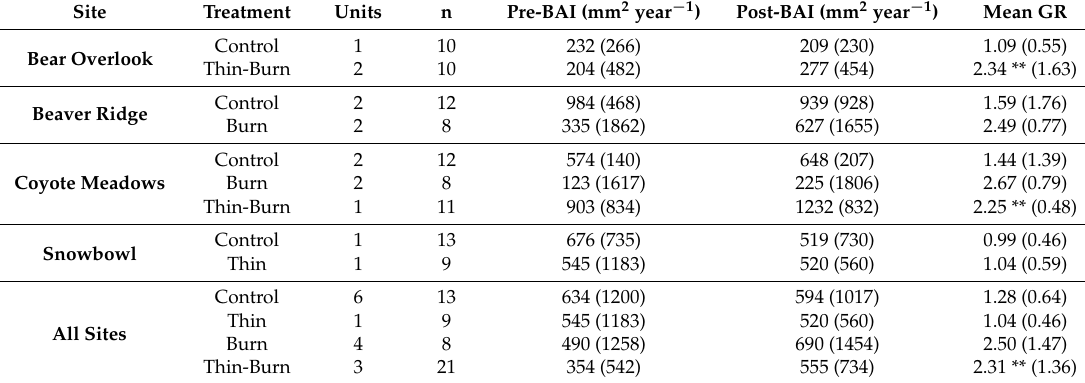
Table 4. Site, treatment, number of units, tree sample size (n), mean BAI (basal area increment; mm 2 year − 1 ) before and after treatment with standard deviation in parenthesis, mean growth ratio (GR), and standard deviation in parenthesis. ** = statistically significant difference at p < 0.05, GR greater than 1 indicates an increase in growth after treatment. GR less than 1 indicates a decrease in growth after treatment.